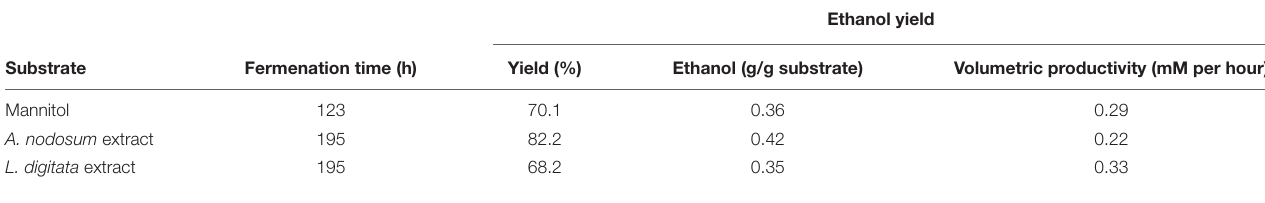
TABLE 4 | Features of kinetic experiments with Thermoanaerobacter pseudoethanolicus (DSM 2355) on mannitol and macro algal extracts.